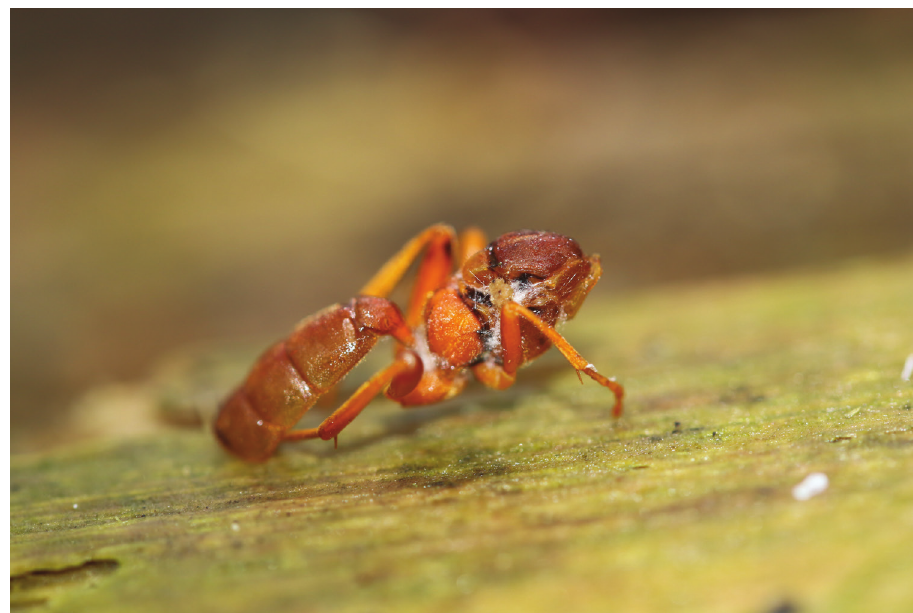
Figure 9. A dead specimen of Lymantrichneumon disparis (Poda, 1761) with traces of unidentified fungi; Belgium, Zillebeke (Papenelst), 23 December 2019. Fons